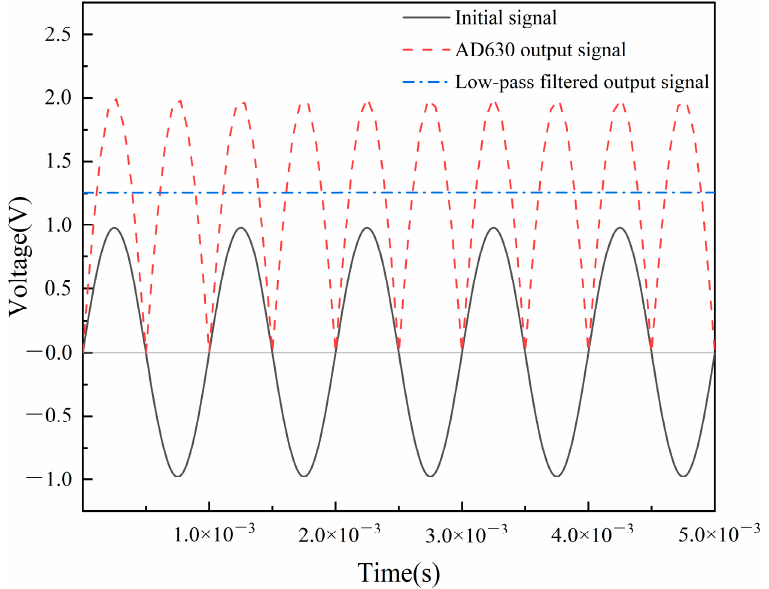
Figure 7. Operating principle of the AD630 signal conditioning circuit under a sinusoidal excitation signal.